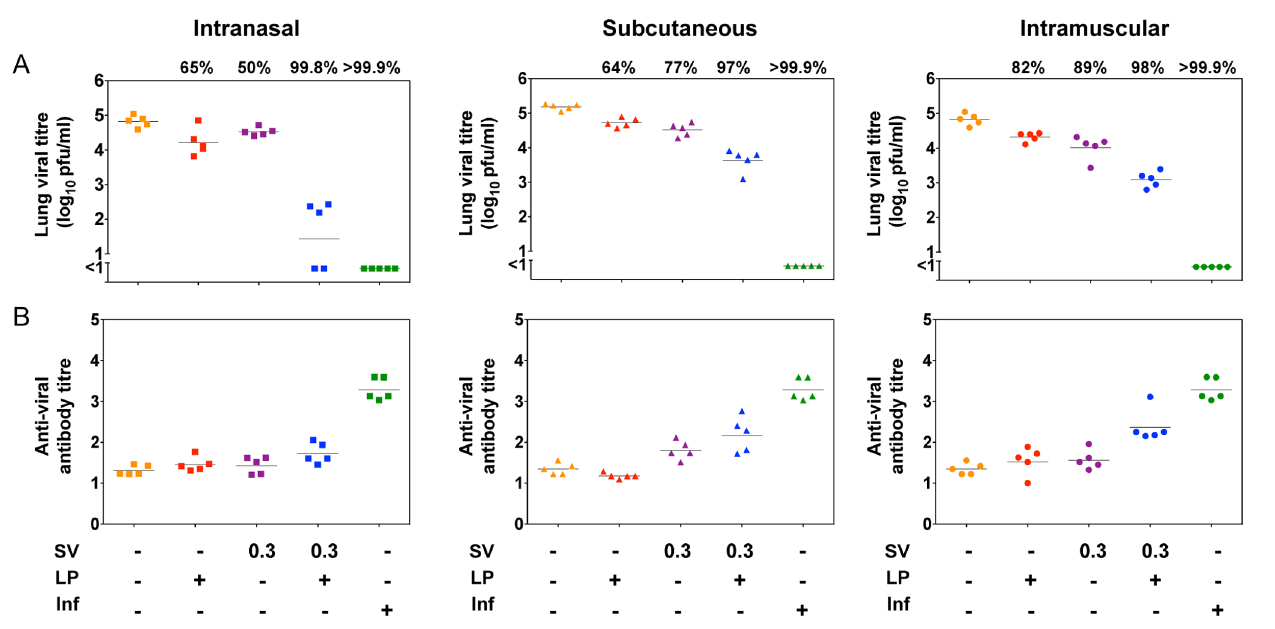
Fig. 3. Viral clearance and antibody titre induced by immunisation with the low dose combination vaccine and its individual components. Mice were immunised once by the i.n. (squares), s.c. (triangles) or i.m. (circles) routes with 10 nmol lipopeptide (LP), 0.3 m g of HA as split virus (SV) or a combination of both components as indicated ( + ) or infected with 10 4.5 pfu of virus (Inf). Control mice received PBS. One month post-immunisation, mice were challenged by the i.n. route with 10 4.5 pfu of virus, lungs were removed 5 days later and pulmonary viral titre determined by plaque formation (A). Mice were bled prior to challenge, and the virus-specific antibody response in sera measured by ELISA (B). Symbols represent the titres for individual mice, and the line indicates the geometric mean for the group (n 5 5). The numbers above the data sets refer to the average percentage decrease in viral load compared to PBS control mice.